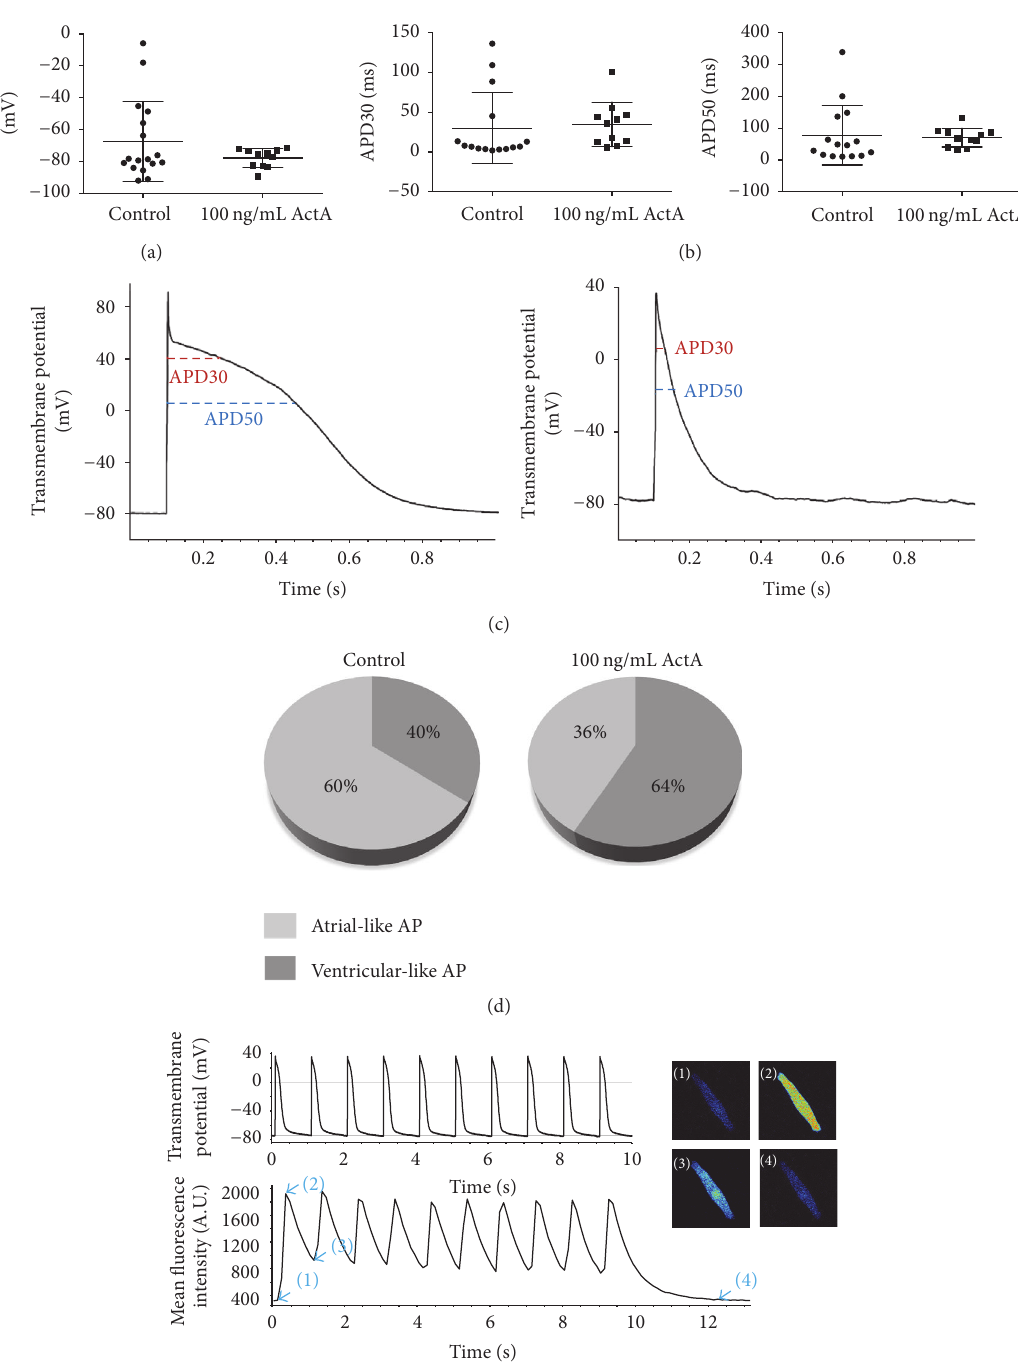
Figure 7: Phenotyping CM differentiation showed both atrial- and ventricular-like (action potentials) APs. (a) Resting membrane potential (RMP)ofhumanESCs-CMs,measuredduringcurrentclamp(whole-cellpatchclamprecording)withorwithoutapretreatmentof100 ng/mL ActA. Each data point is a single cell measurement. (b) AP duration at 30% and 50% repolarization (APD30 and APD50). (c) Example of AP from a typical ventricular-like cell ( left panel ) and an atrial-like cell ( right panel ). (d) Percentages of CMs exhibiting an atrial-like or ventricular-like AP phenotype with and without ActA addition. (e) Simultaneous intracellular Ca 2+ measurements using Fluo-4 and current clamp recording in a human ESC differentiated into